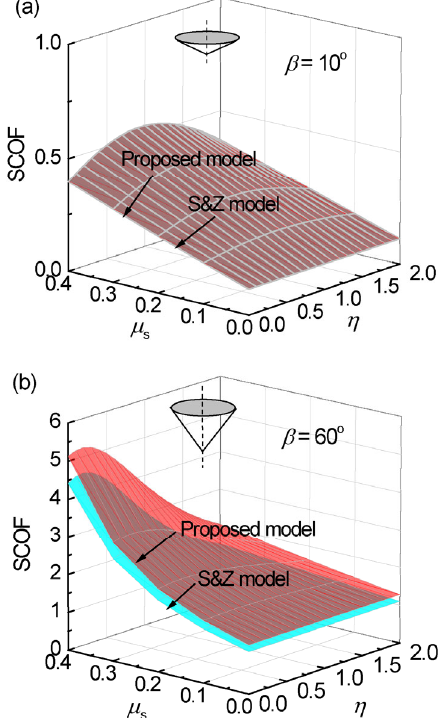
Fig. 6 SCOFs of the conical tip-polymer substrate systems with a zero-recovery angle: (a)  = 10° and (b)  = 60°.